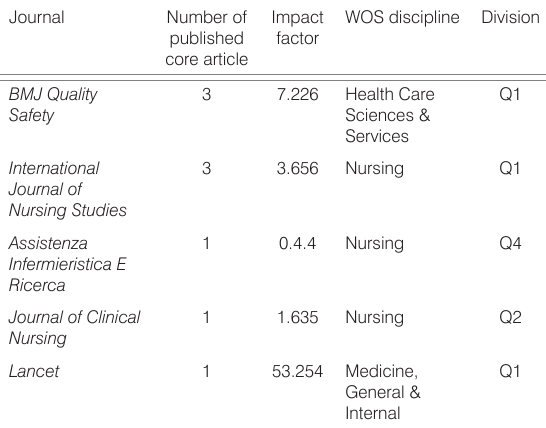
Table 2. Journal distribution of Research Frontier